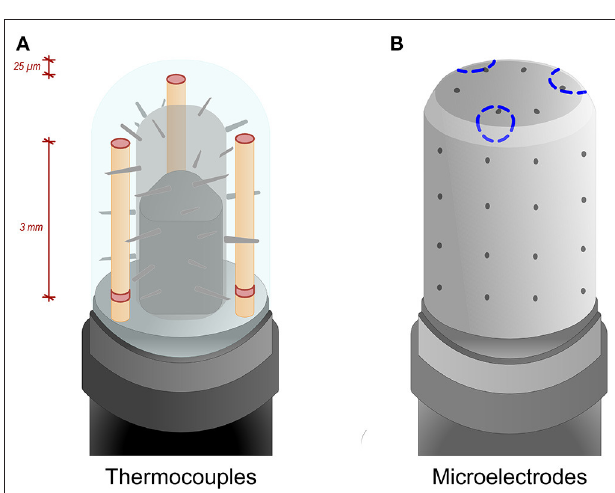
FIGURE 2 | (A,B) QDOT Micro ablation catheter illustration. (A) The ablation catheter incorporates six thermocouples (columns with red disk) symmetrically embedded in the tip for the purpose of highly accurate local temperature measurement. The three distal thermocouples are positioned at a distance of 25 µ m from the tip, while the proximal ones are positioned 3mm proximally. (B) Three microelectrodes (blue dotted circles) are also located in the catheter tip. Each has a surface area of 0.17 mm 2 and an interelectrode spacing of